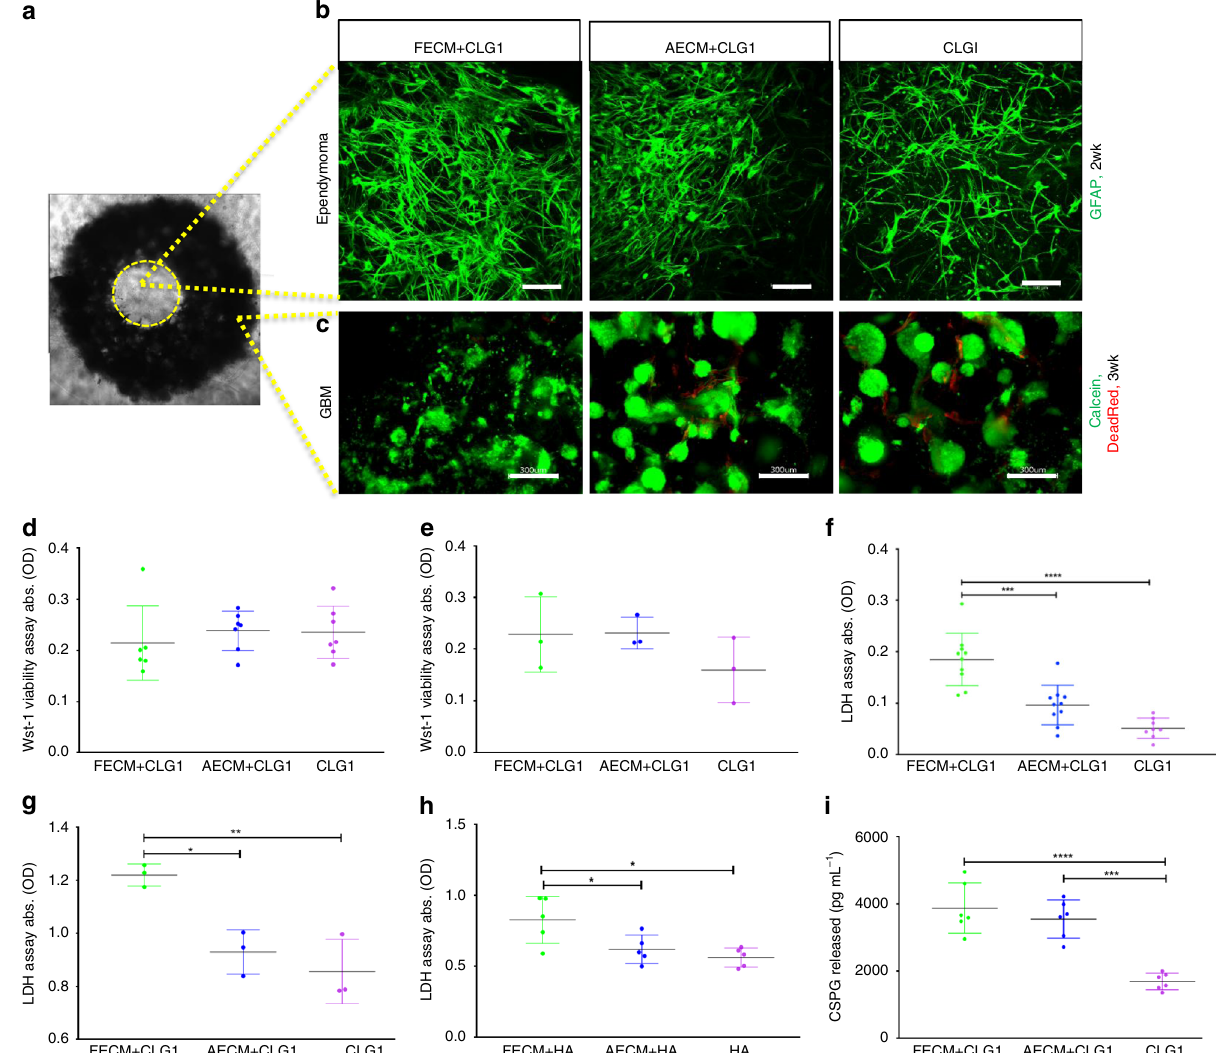
Fig. 2 Patient-derived anaplastic ependymoma and glioblastoma in silk scaffold-based 3D constructs. a Bright fi eld image of donut-shaped silk scaffold seeded with tumor cells and infused with hydrogel. Systems infused with either collagen I (CLG1) or hyaluronic acid (HA) hydrogels supplemented with porcine brain- derived ECM (Fetal ECM: FECM, Adult ECM: AECM), cultured in chemically de fi ned media lacking FBS. The middle circular window indicated by the yellow outline demarcates a distinct region within the construct that is exclusively hydrogel fi lled and not initially seeded with cells but where tumor cells can migrate. b Migration of anaplastic ependymoma cells at 2 week shown by GFAP staining within the middle hydrogel window of the 3D donut-shaped constructs. Presence of GFAP-positive glial cells matched histopathology reports. Scale bar, 100 μ m, Max projection of z-stack imaged in Leica SP8 confocal. c Growth of glioblastoma (GBM) at 3 week shown by live calcein and dead red staining within the ring portion of the 3D donut-shaped constructs. GBM grew more as spheres and did not in fi ltrate the middle window at earlier time points in CLG1-based hydrogels. Scale bar, 300 μ m, Max projection of z-stack imaged in Leica SP8 confocal. Wst-1 viability assay at 2 week in 3D ependymoma d and 1.5 mo GBM e silk-CLG1 cultures, respectively indicating similar viability across all ECM conditions. f Lactate dehydrogenase (LDH) release assay at 2 week in 3D ependymoma cultures. Statistically signi fi cant difference in the LDH release in FECM condition in comparison to AECM or CLG1 alone. g LDH release assay at 1.5 mo in 3D GBM silk-CLG1 cultures, showing statistically signi fi cant (higher) LDH release in FECM condition assuming a Gaussian distribution. h LDH release assay in 3D GBM silk-HA cultures, showing statistically signi fi cant (higher) LDH release in FECM condition at 1 mo. i Chondroitin sulfate proteoglycan (CSPG) release observed to be statistically signi fi cant (higher) in the FECM and AECM containing constructs at 3 week in 3D ependymoma cultures. Ordinary one-way ANOVA with Tukey ’ s post-hoc, F>6.958, * p <0.0412, ** p =